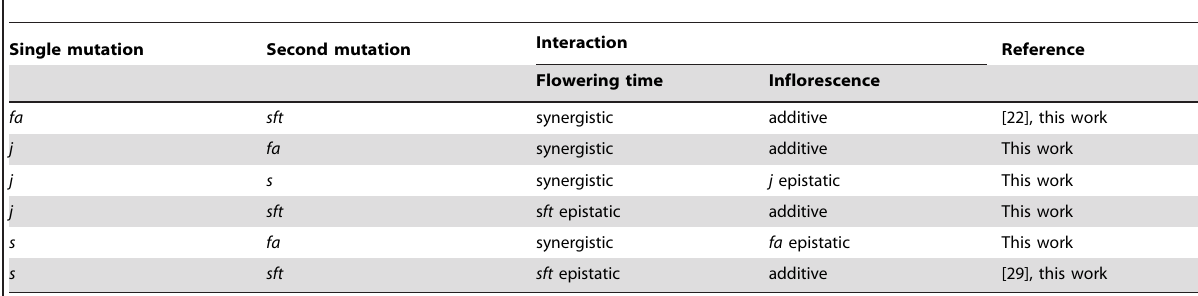
Table 2. Tomato double mutants produced and analysed in this study.